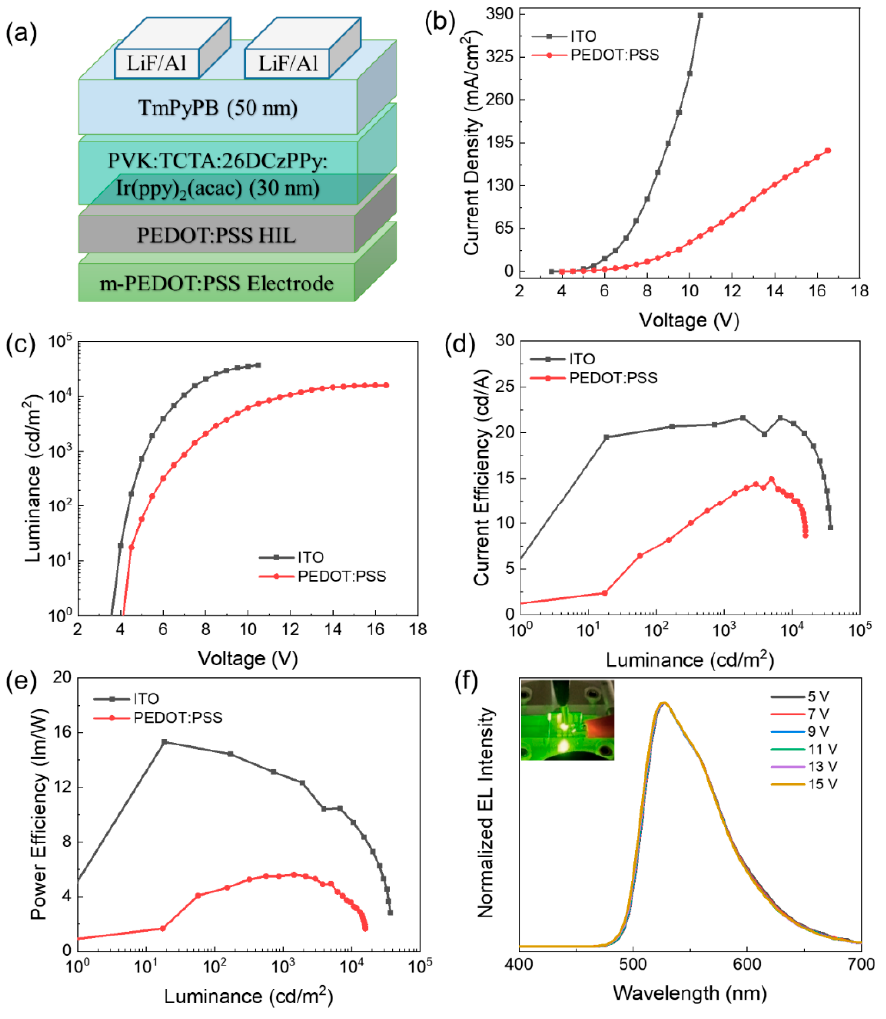
Figure 8. ( a ) Schematic device structure of the solution-processed OLED. ( b ) J - V , ( c ) L - V , ( d ) CE- L , ( e ) PE- L , and ( f ) EL spectra at different driving voltages of the OLEDs (Inset: The luminescence image).